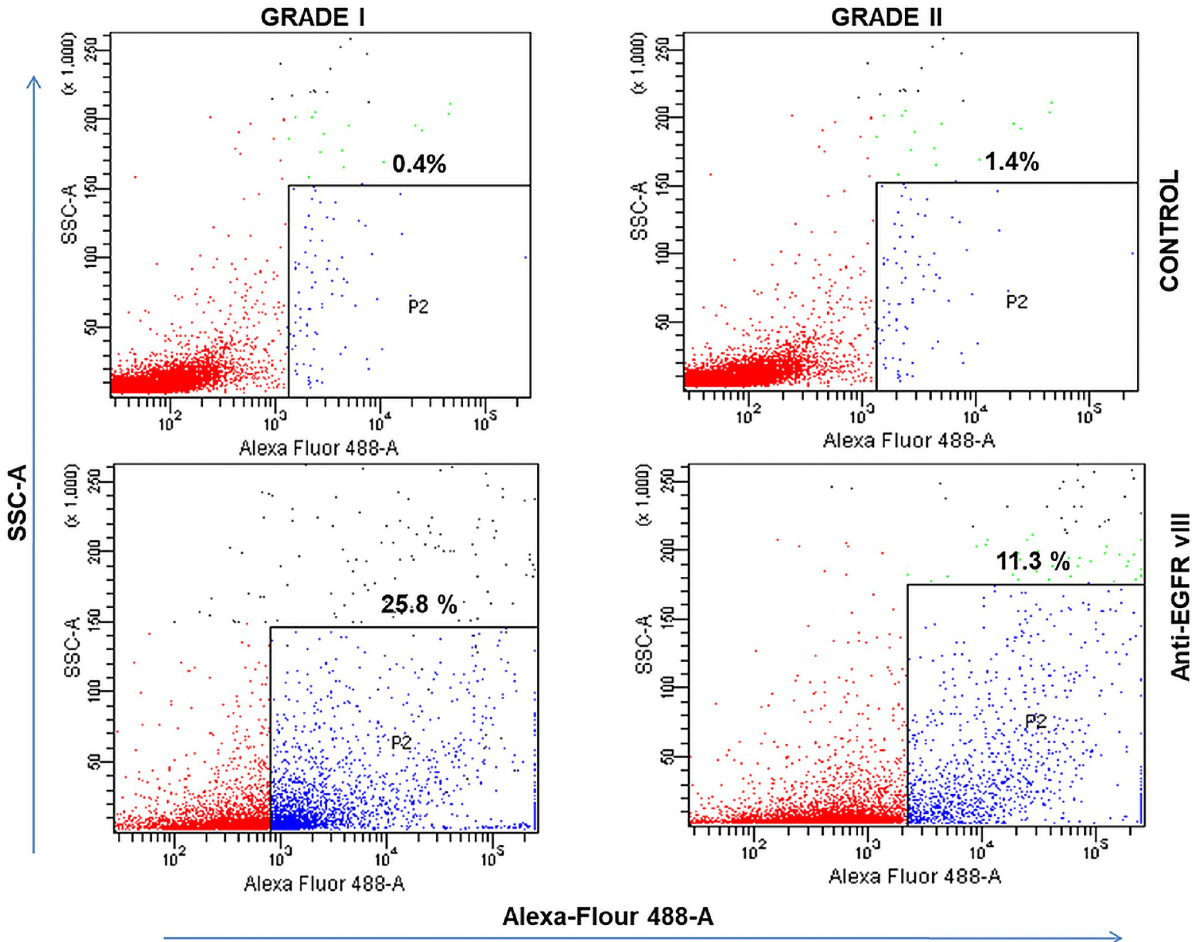
Fig 5. Generation of EGFRvIII − and EGFRvIII+ sublines as determined via FACS. MG Grade I representing 25.8% EGFRvIII (Alexa flour 488) positive cells (SSC vs Alexa Flour 488) while Grade II representing 11.1% EGFRvIII (Alexa flour 488) positive cells (SSC vs Alexa Flour 488). There is about 2 folds decrease in EGFR V3+ cells in grade II as compared to grade I. Unlabelled cells were used as controls in both grade I and grade II.